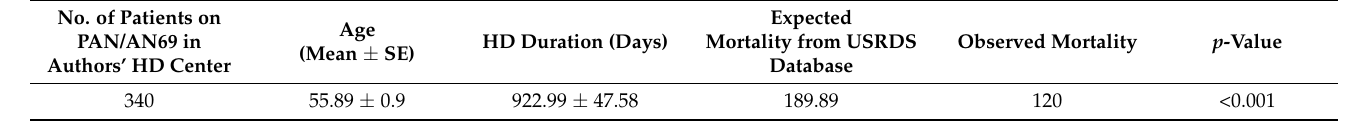
Table 4. Survival of hemodialysis patients treated with PAN/AN69 membrane